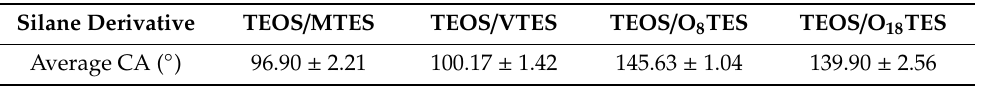
Table 4. Water static contact angles measured on various hybrid films deposited onto glass slides.